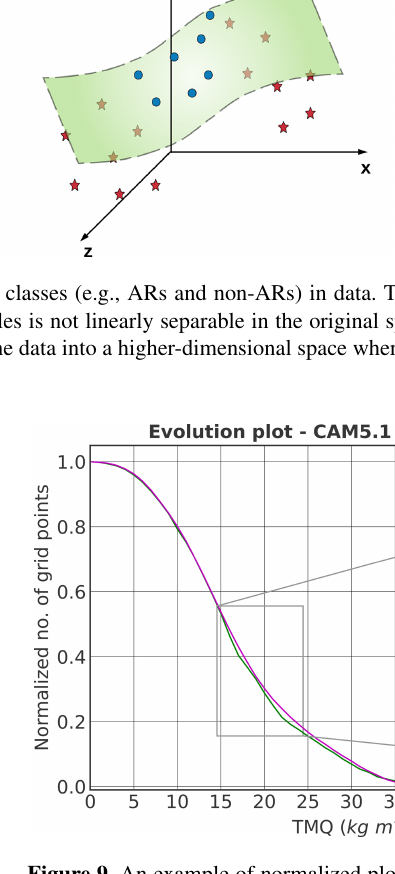
Figure 9. An example of normalized plots of averaged topological feature descriptors for 200km spatial resolution and daily temporal resolution of the CAM5.1 simulation data. Note that the averaged plots for the ARs and non-ARs are very similar and it is hard to differentiate them by eye. However, a ML model can be trained to distinguish these two categories of events, by transforming the data into a high-dimensional space where a unique hyperplane exists that cleanly separates the two event categories (see Sect.